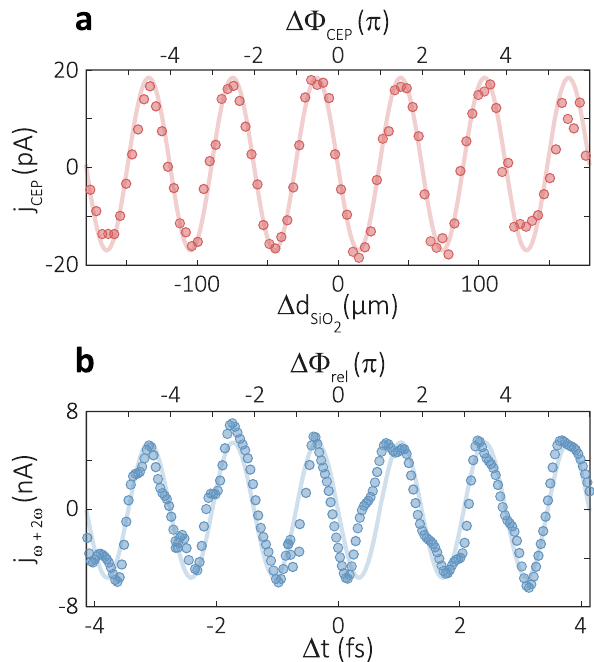
Figure 2: Measured residual current in graphene. (a) CEP-dependent current induced by a single laser pulse as a function of the relative thickness of fused silica in the beam path. A 5.4 fs short pulse at 800 nm central wavelength with 2.8 V/nm peak field strength is applied. (b) Delay-dependent current induced by a 𝜔 + 2 𝜔 laser field as a function of the relative delay. The fundamental pulse has identical properties as in (a), the second harmonic pulse (2 𝜔 ) at 400 nm central wavelength is 19 fs long and reaches a peak field of 0.3 V/nm. For both experiments (a and b) the laser pulses were focused on identical graphene strips with 10 μ m length such that neighboring electrodes were not illuminated. Clearly, the current is much larger in